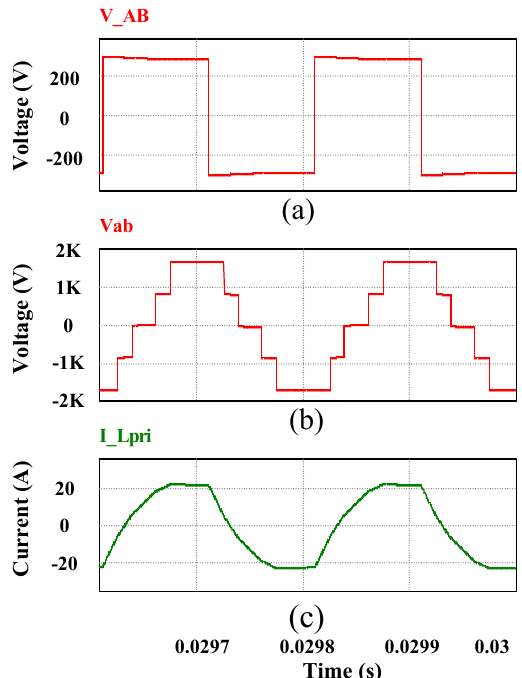
; ( b ) secondary 5L voltage (cid:1874) (cid:3002)(cid:3003) (cid:3013)